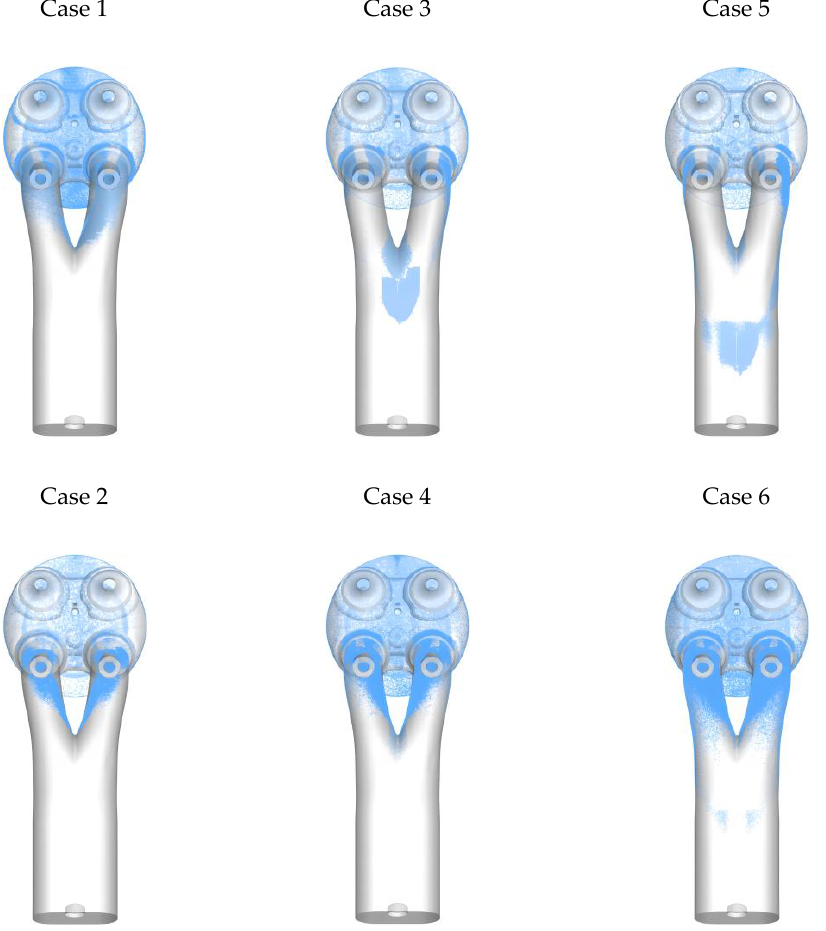
Figure 9. The distribution of water at the moment of ignition time in different water injection cases (CR = 10.3, ignition time = − 14 degCA).